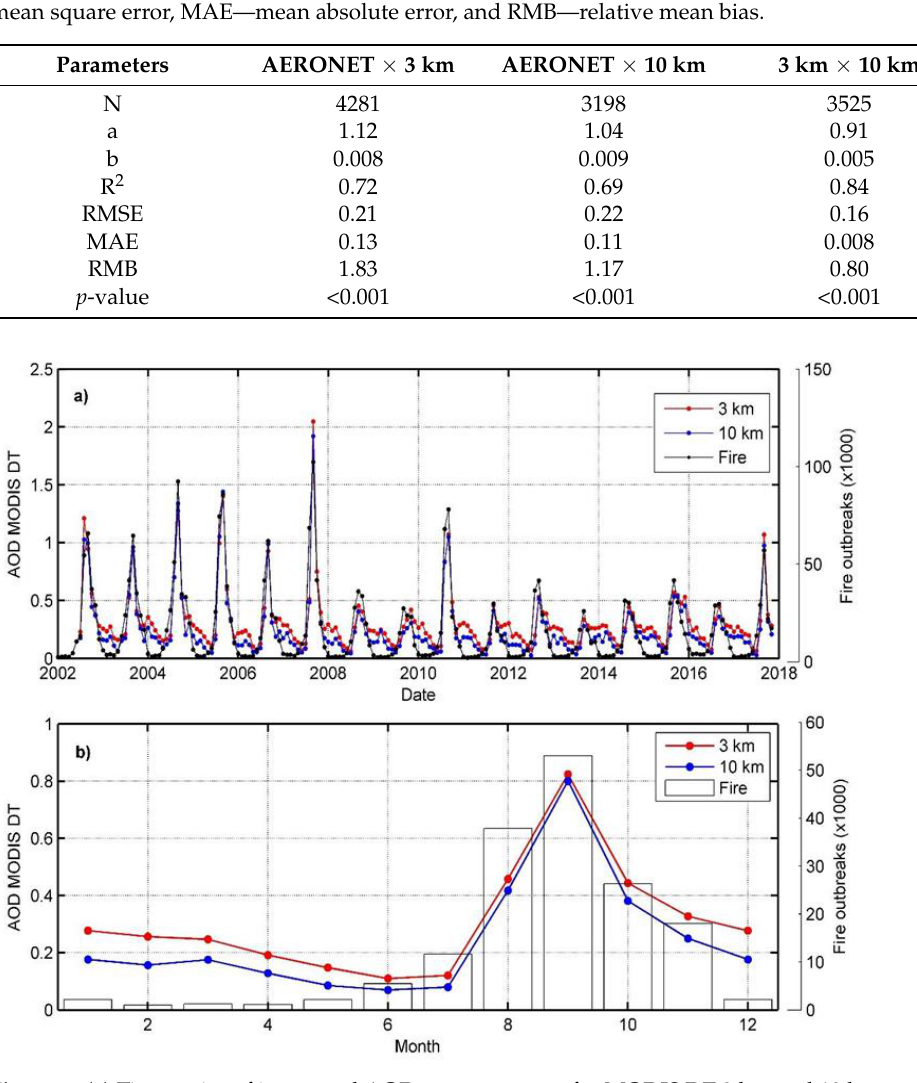
Table 3. Statistical parameters calculated for the linear regression model (shown in Figure 6c,d) between the integrated measures of all sites, AOD AERONET × AOD MODIS DT 3 km, AOD